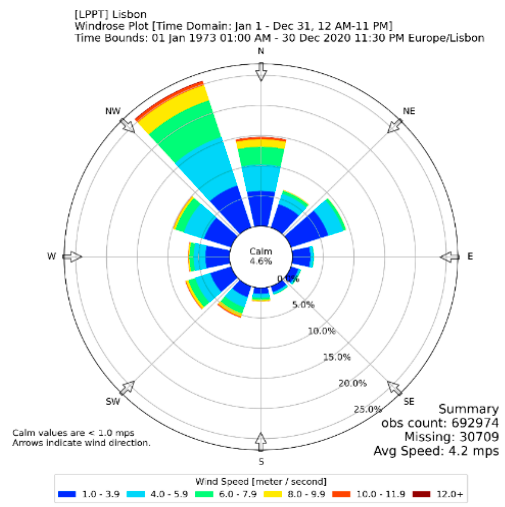
Figure 1. Wind regime at the Lisbon/Airport from 1971–2020. Source: The Iowa Environmental Mesonet (IEM), Iowa University. https://mesonet.agron.iastate.edu (accessed on 21 May 2020).